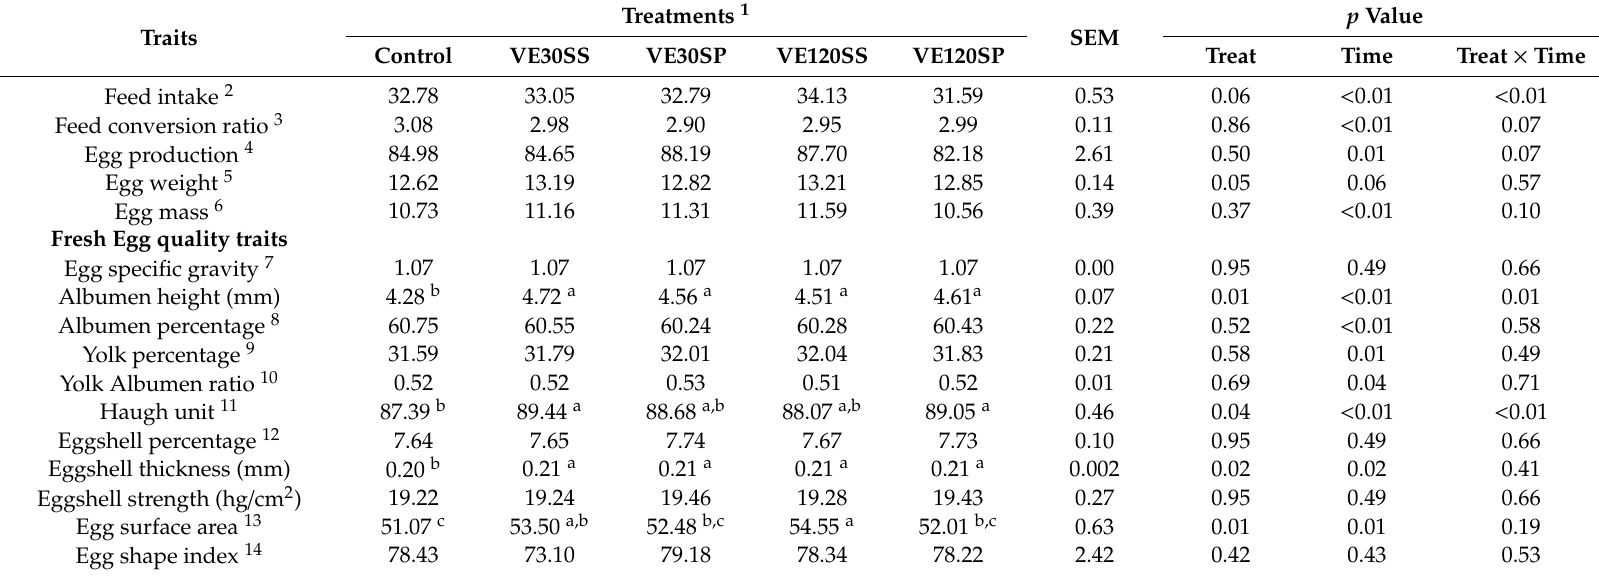
Table 2. Productive performance and fresh egg quality traits of Japanese quails fed di ff erent levels of VE and Selenium sources.